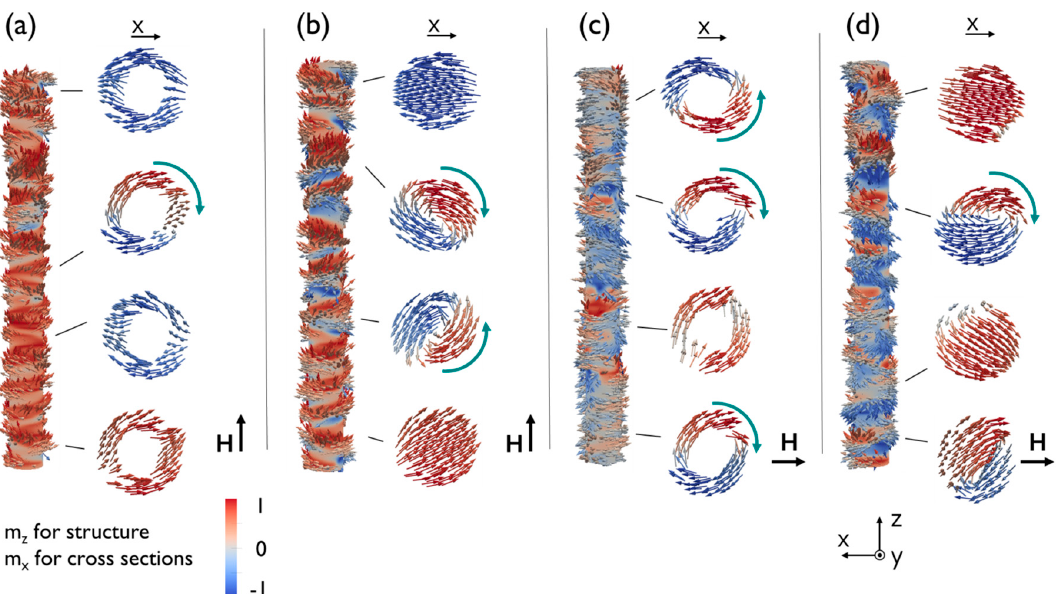
Figure 5. (Color online) From left to right, four figure compositions showing the magnetization configurations at remanence of single nanotubes ( a , c ) and nanowires ( b , d ) for parallel ( a , b ) and perpendicular ( c , d ) applied field orientations (as indicated by black arrows). On the left side of each composition, the nanowire/nanotube (the structure) is colored by the longitudinal m z component of magnetization. On the right side of each composition, cross sections at the marked places are colored by the transverse component m x of magnetization. Green arrows over vortex cross-sections indicate the vortex circulation.